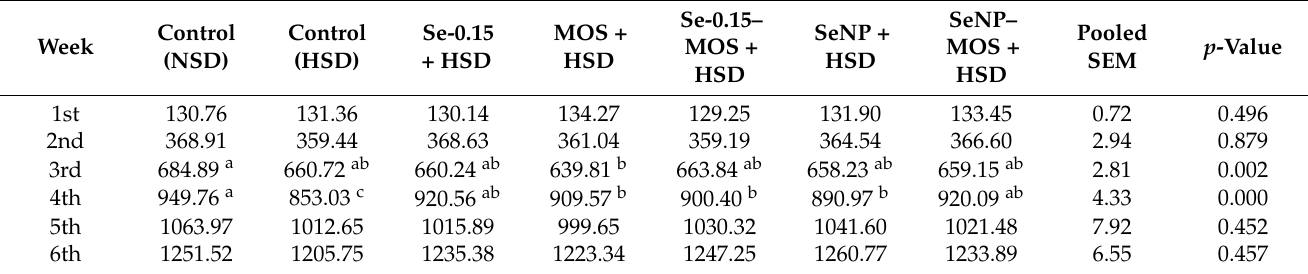
Table 5. Effect of selenium nanoparticles–MOS on weekly feed intake (grams) of broiler chickens reared under higher stocking